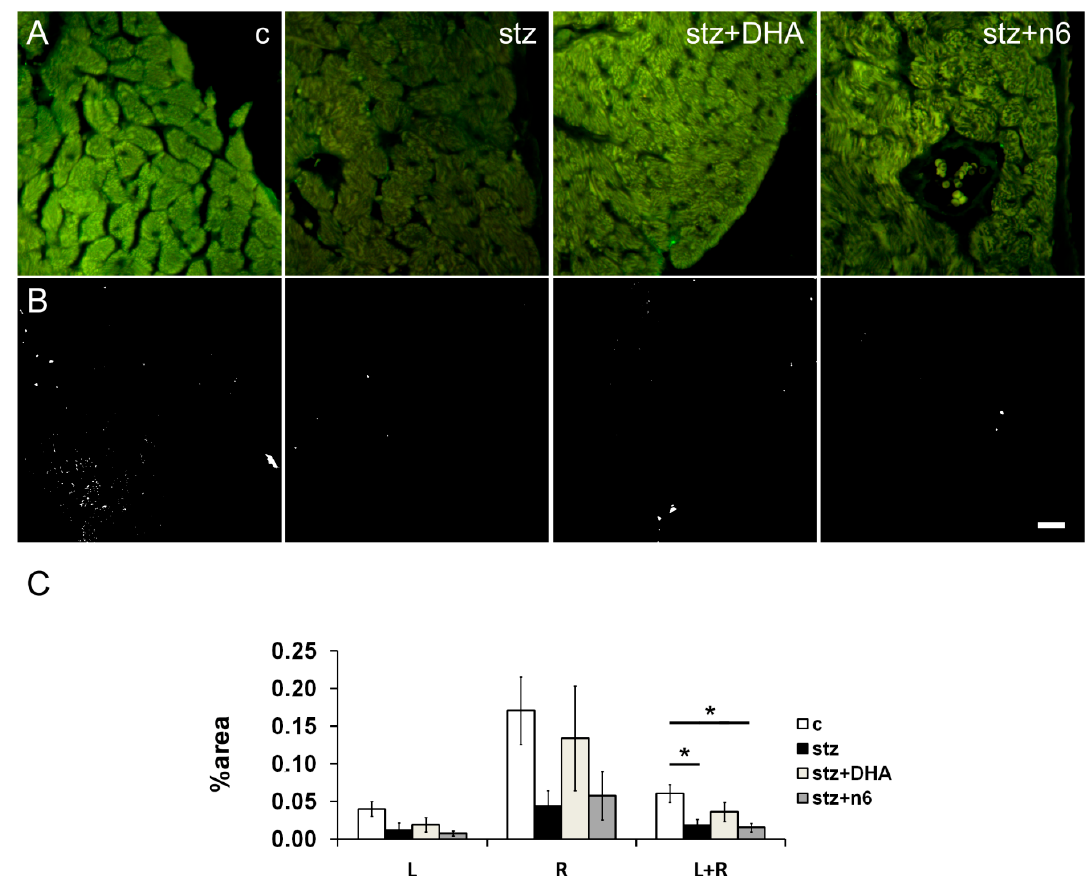
Figure 6. Choline acetyl transferase immunoreactive nerve fiber density in subendocardial areas of cardiac septum. ( A ) Representative photomicrographs of right side of the subendocardial area of the cardiac septum stained for ChAT, a marker for parasympathetic fibers (green). c—Control group; stz—diabetic group fed standard diet (both diets n6 / n3 ratio ≈ 7); stz + DHA—Diabetic group supplemented with n3 PUFA (2.5% of fish oil, containing 16% eicosapentaenoic acid—EPA and 19% docosahexaenoic acid—DHA; n6 / n3 ratio of ≈ 1); stz + n6—diabetic group fed with diet that contained 2.5% sunflower oil (n6 / n3 ratio ≈ 60). ( B ) Threshold figures from A; white—Nerve fiber area. ( C )—Neuronal density expressed as percentage of the tissue area. *— p < 0.05 di ff erence between indicated groups. Scale-bar = 20 µ